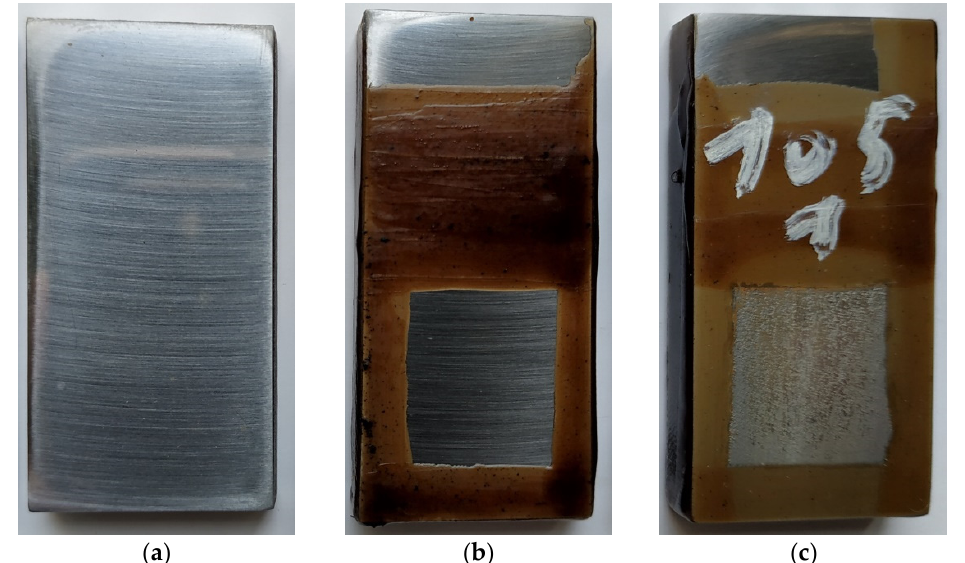
Figure 2. Type of samples for electrochemical tests: ( a ) Before testing and paraffin coating; ( b ) Before testing after paraffin coating; ( c ) After testing.